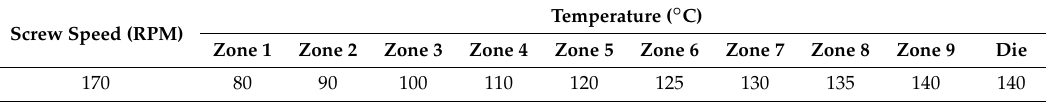
Table 3. Extrusion conditions of